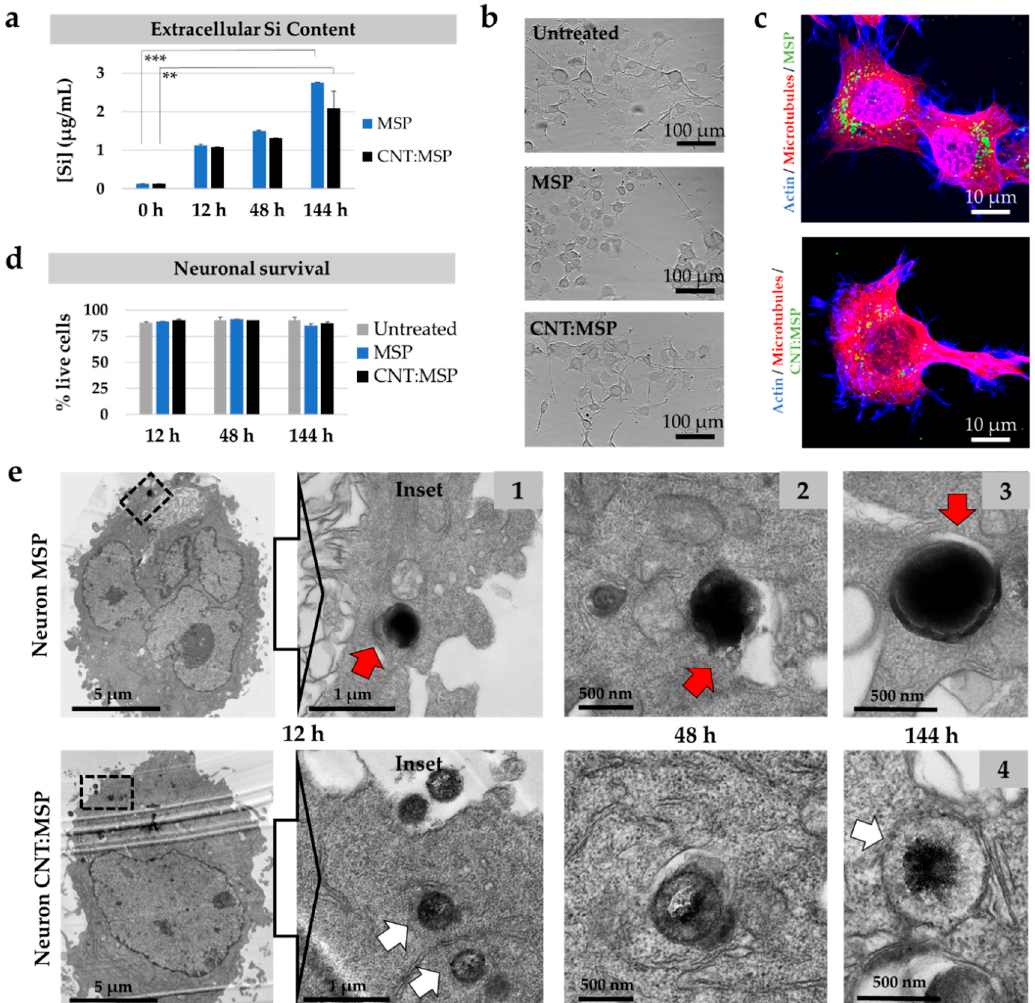
Figure 7. Intracellular route and degradation of MSP in neurons. ( a ) Quantitative ICP-OES analysis of extracellular Si in cultures of NSC-34 neurons exposed to MSP and CNT:MSP. The rise of the Si species corroborates particle dissolution in these cells at the indicated times (** p < 0.025, *** p < 0.005). ( b ) Phase-contrast images of control neuronal cultures and cells exposed to 15 μ g/mL of MSP and CNT:MSP for 6 days. No deleterious morphological changes were observed. ( c ) Fluorescent confocal images of neurons displaying MSP and CNT:MSP (green channel). No abnormalities in the cytoskeleton of microtubules (red channel) or actin (blue channels) were detected. ( d ) Neuronal survival upon exposure to the two types of particles was not affected. ( e ) TEM images of ultrathin sections of motor neurons containing intracellular MSP (top) and CNT:MSP (bottom). Particles reproduce the same destinies and degradation patterns described for epithelial cells. Red arrow points at the endosomal membranes surrounding a particle. White arrow shows the eroded surface of a cytosolic CNT:MSP.